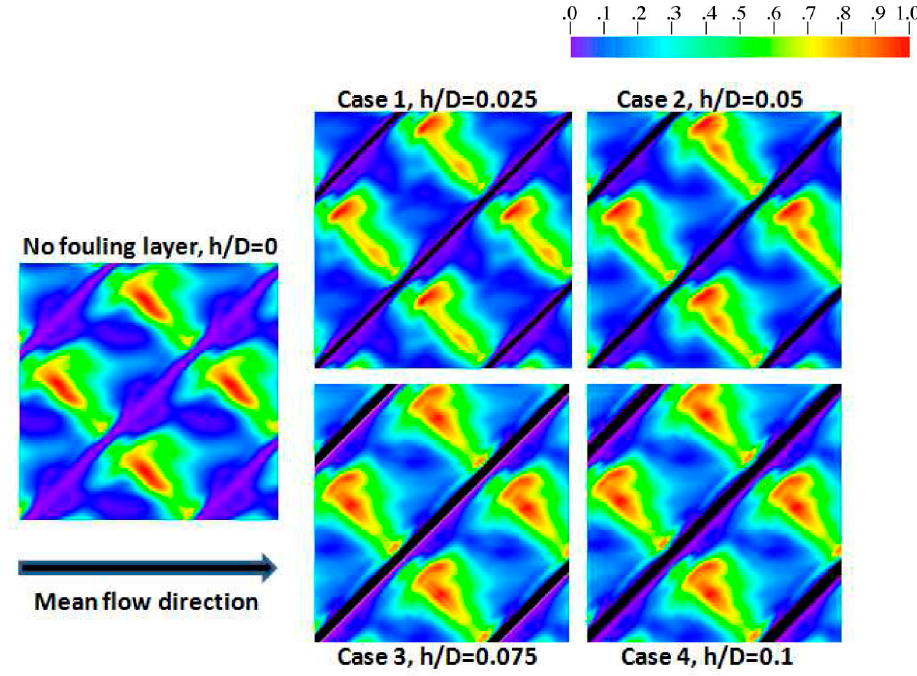
Figure 7. A view of spatial distribution of the local time-averaged shear stress on the membrane surface for the no-fouling geometry ( h / D = 0) compared with distributions for progressively increased fouling-layer thickness; Re ~ 135. In the normalized chromatic scale, the values of 0 and 1 correspond to the minimum and maximum of the plotted variable, respectively.